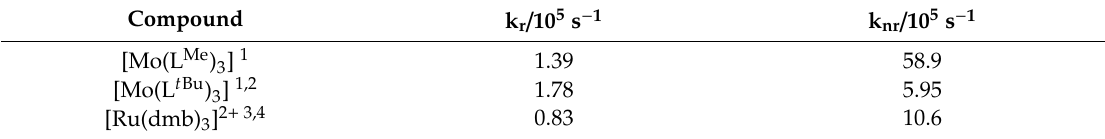
Table 2. Rate constants for radiative (k r ) and nonradiative (k nr ) 3 MLCT excited-state relaxation in solution at room